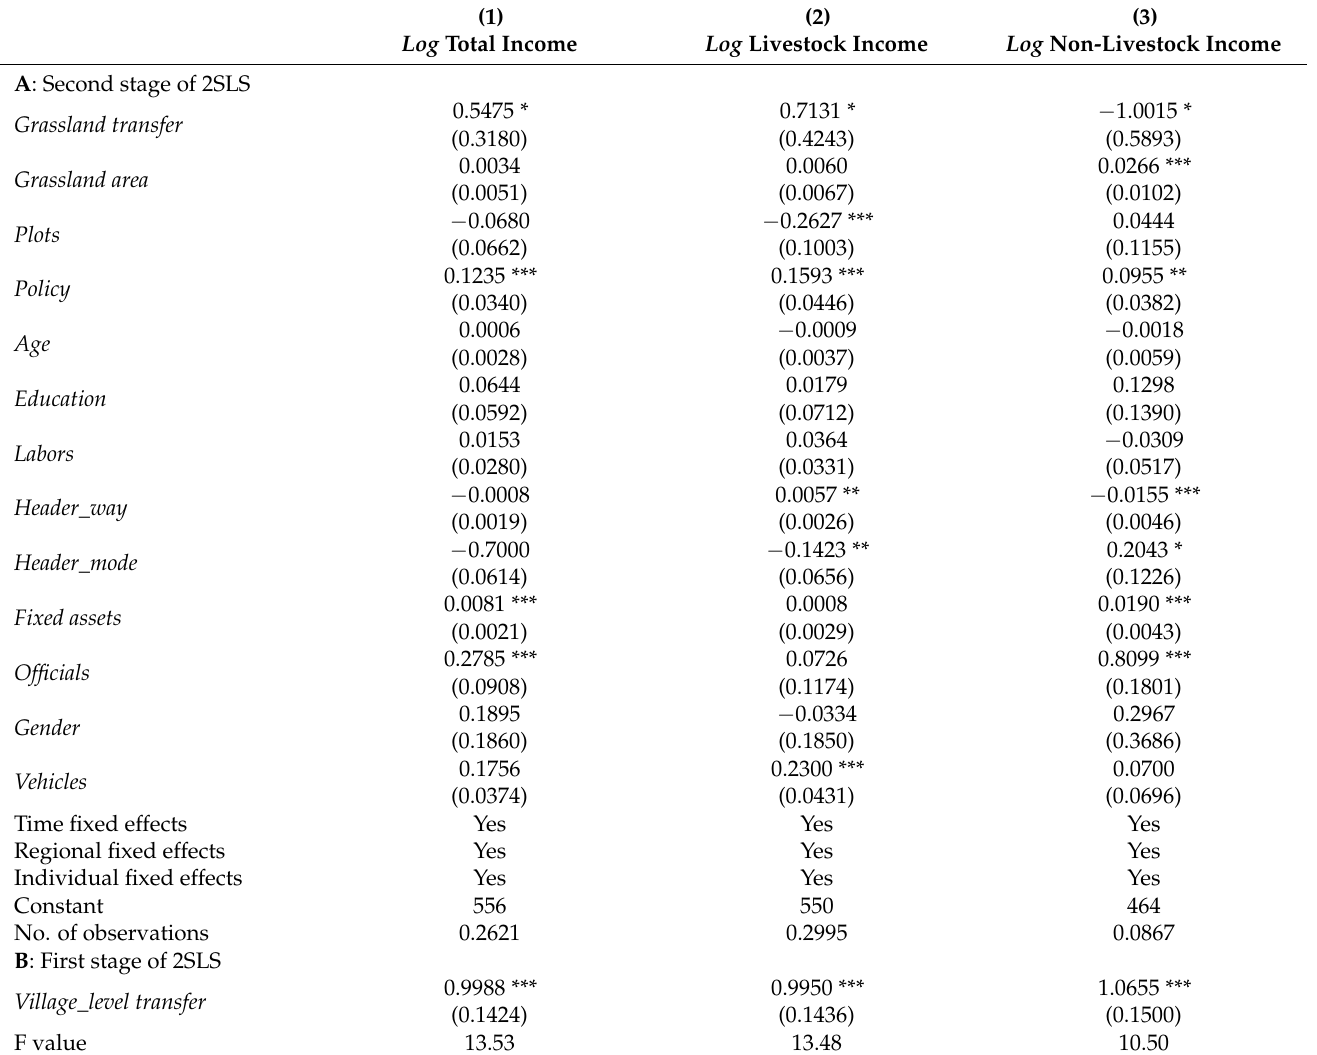
Table 3. Estimated results of instrument variable